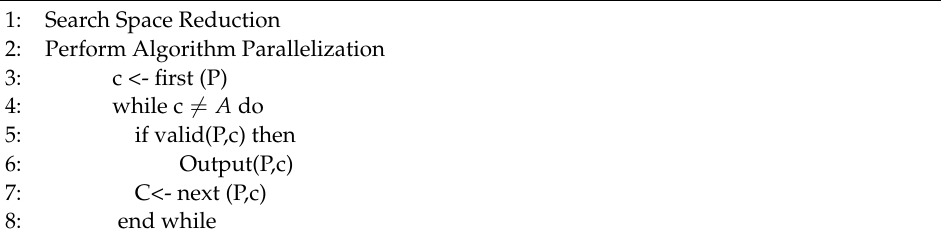
Algorithm 1: Exhaustive Search Algorithm. (Procedure Exhaustive